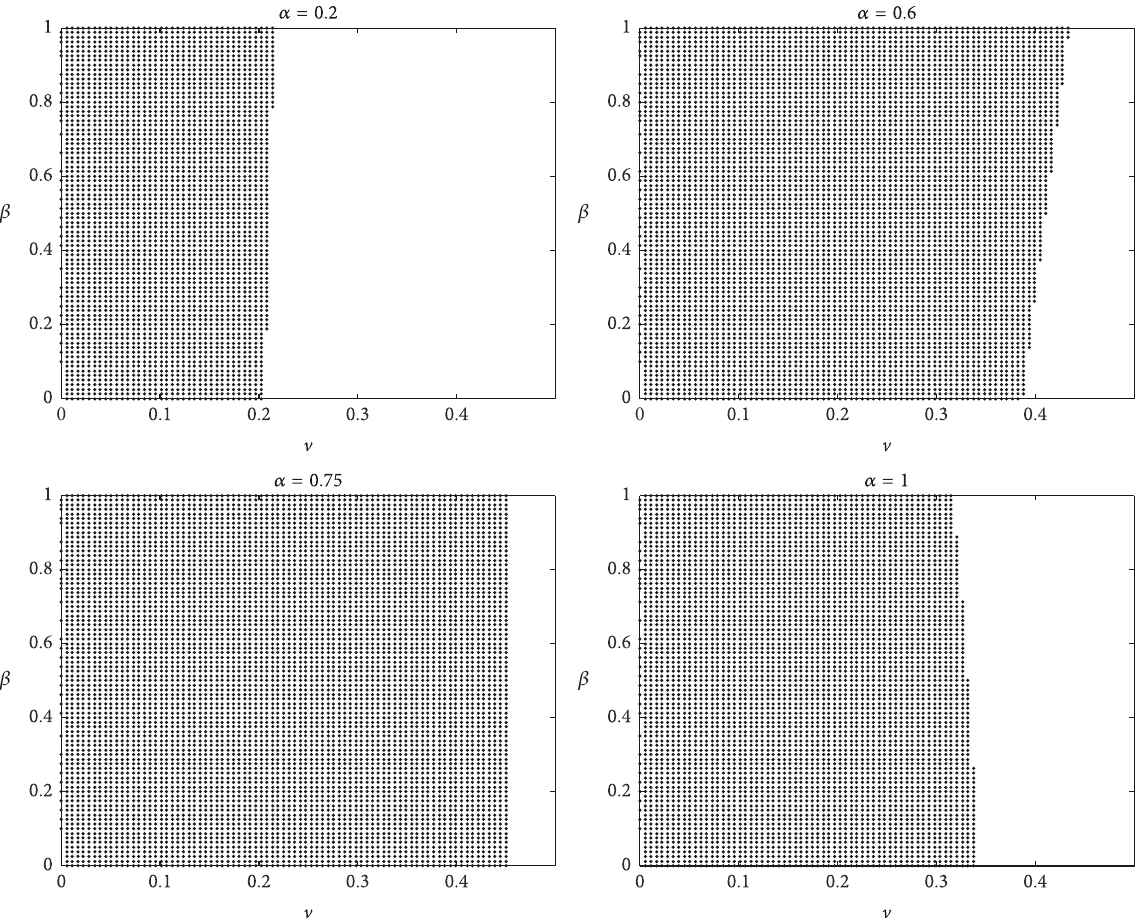
Figure 4: Stability regions in the ( V , 𝛽) -plane for different levels of 𝛼